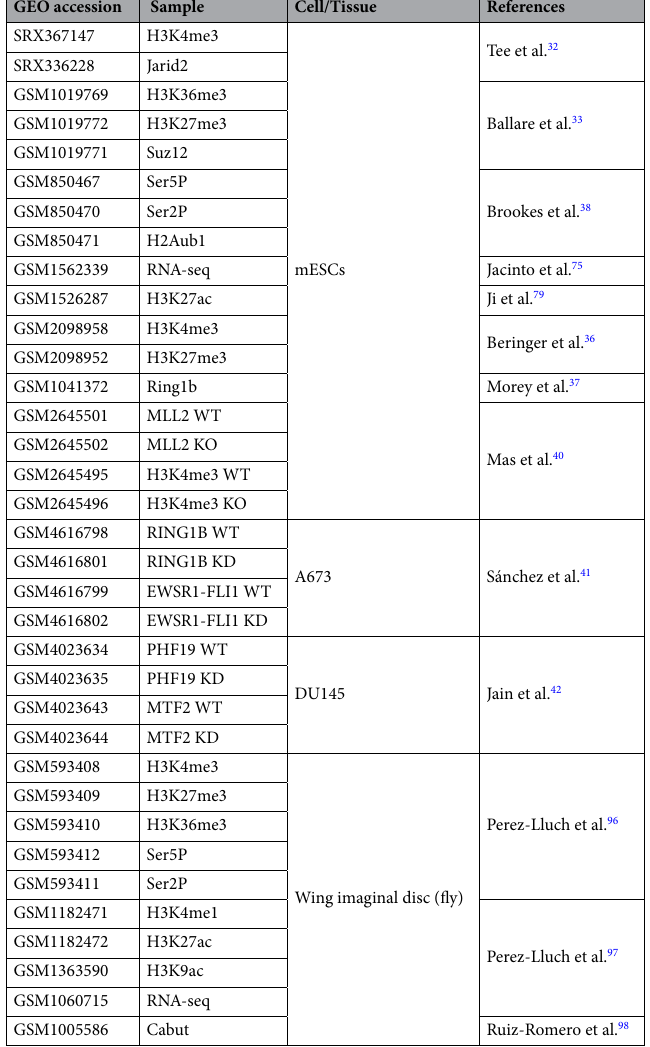
Table 4. List of GEO accession codes of the raw data analyzed in this